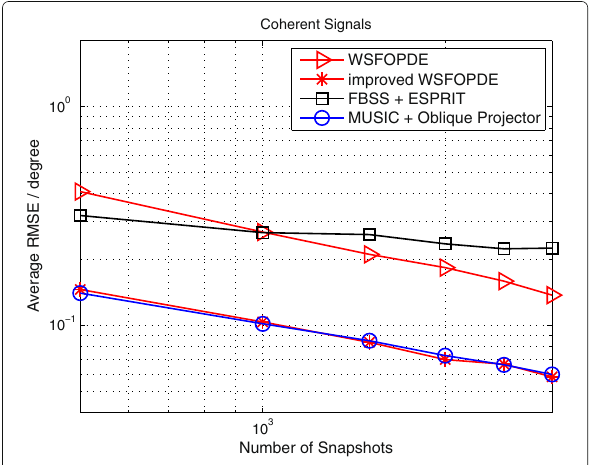
Fig. 5 The performance variation with angular separation between the DOA of mixed signals: uncorrelated